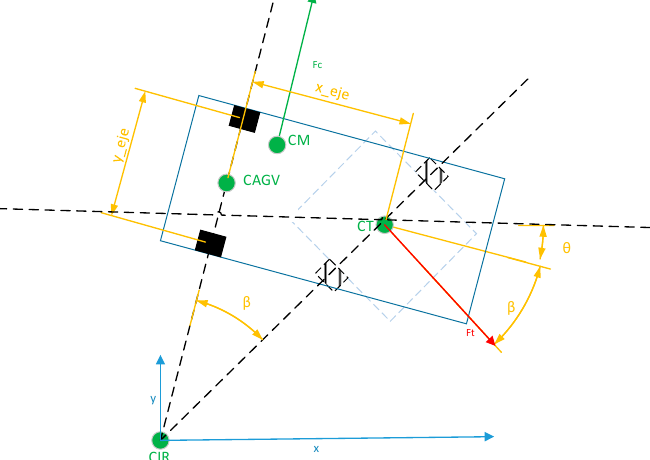
Figure 14. Center of mass and center of traction. Curve movement.